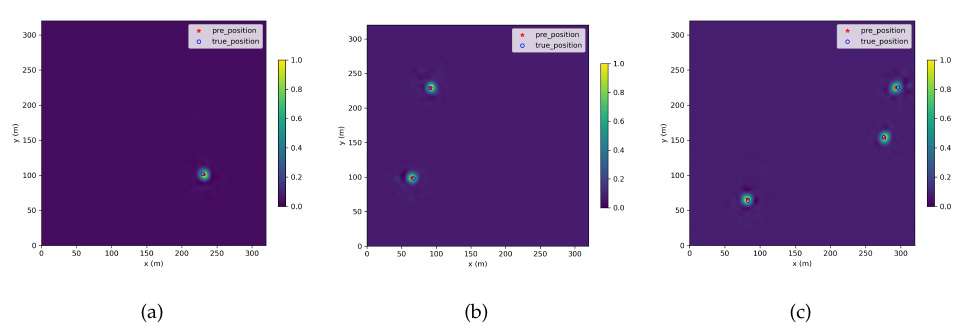
Figure 6. The examples of the predicted heatmap: ( a ) the number of radiation sources is 1; ( b ) the number of radiation sources is 2; ( c ) the number of radiation sources is